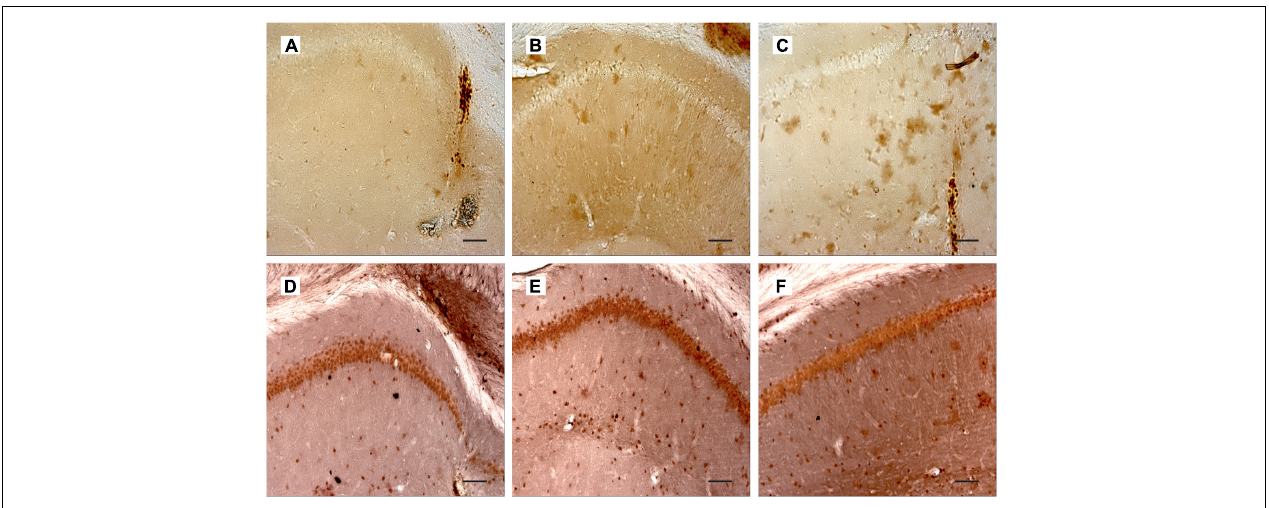
FIGURE 6 | (A–C) Show hippocampal sections from PBS-treated (A) , 192IgG-saporin–treated (B) , and 192IgG-saporin–treated and NGF-overexpressing rats (C) stained with antibodies against TrkA. (D–F) illustrate hippocampal regions from rats treated with PBS (D) , 192IgG-saporin (E) , or 192IgG-saporin and